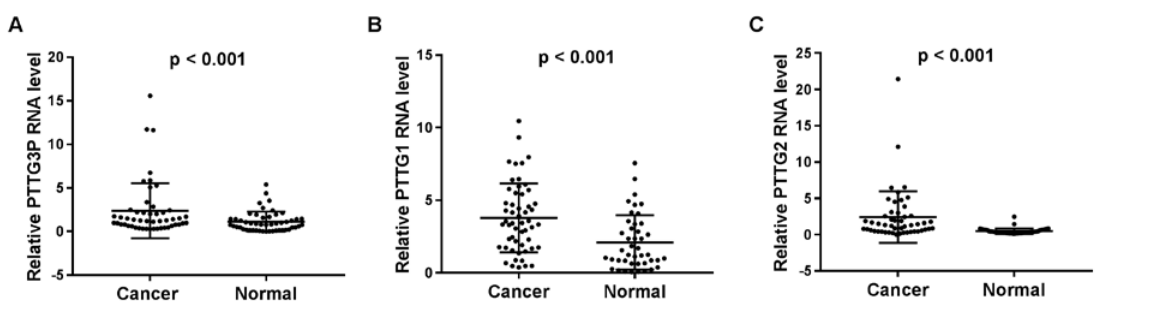
Figure 1: PTTG3P, PTTG1 and PTTG2 expression in esophageal cancer and adjacent normal tissues A-C. Expression of PTTG3P, PTTG1 and PTTG2 mRNA in esophageal cancer tissues and adjacent normal tissues were detected by qRT-PCR. GAPDH was used as an internal control. Data are shown as the mean ± SD of three